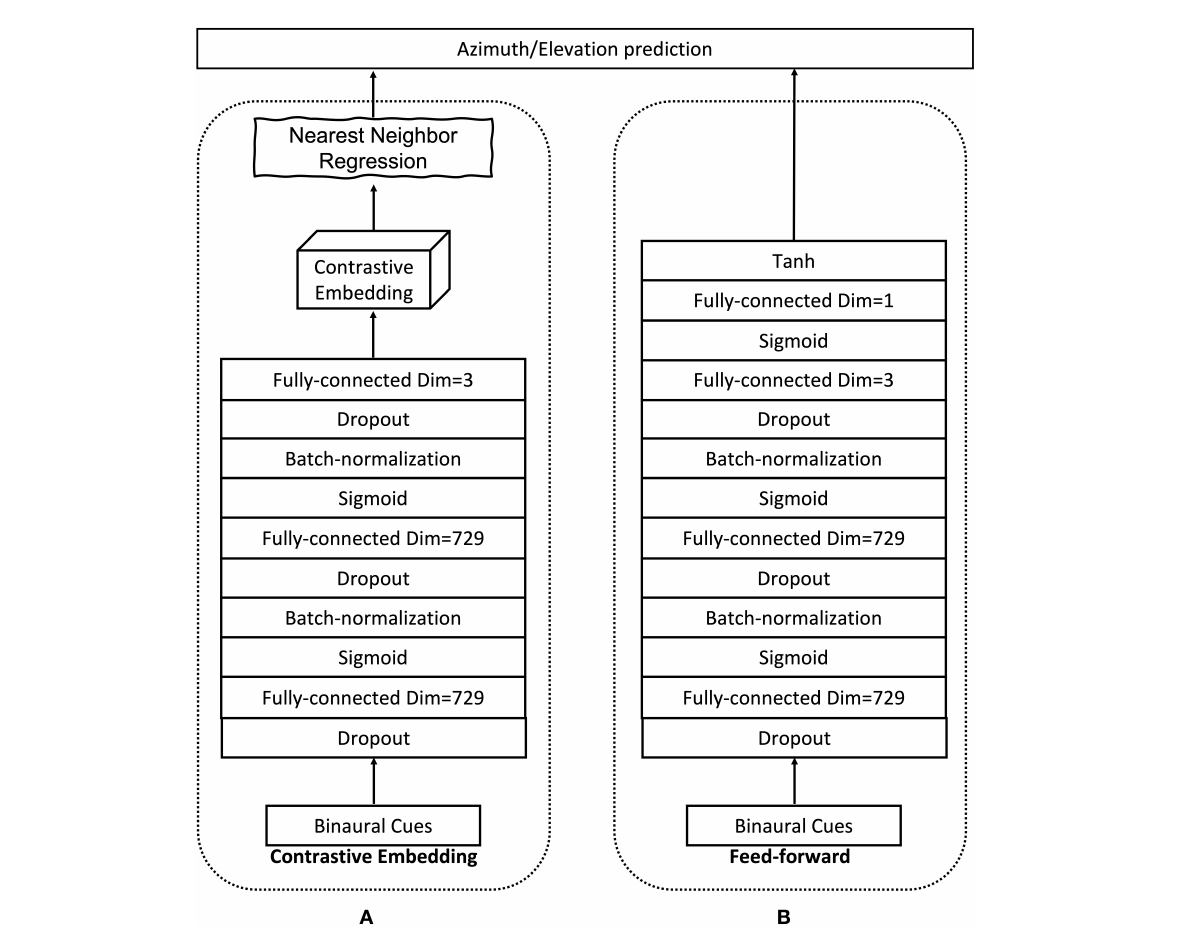
FIGURE1 Model architecture. The proposed contrastive embedding model in (A) , and the feed-forward model in (B) .